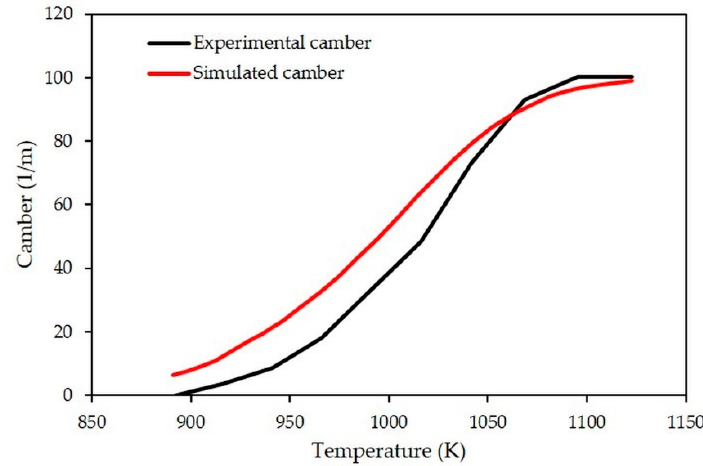
Figure 10. Comparison between simulated and measured evolutions of camber during thermal treatment.